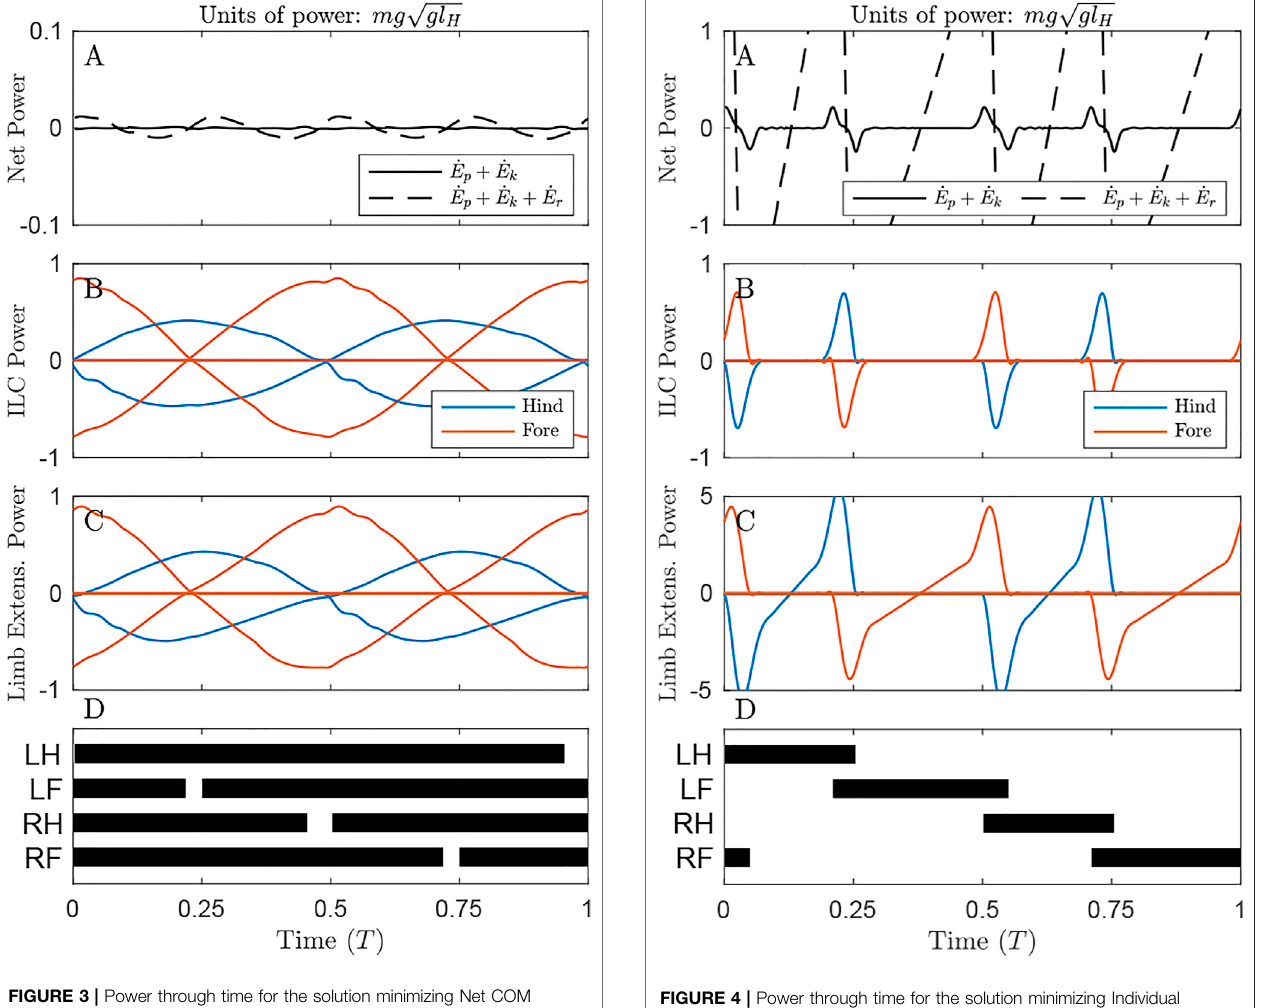
FIGURE 4 | Power through time for the solution minimizing Individual Limbs COM Work under the distributed mass model. (A) There is a small oscillation of the Net COM Power (black line), but very large oscillations in the system energy changes (dash line) due to pronounced pitching (Supplementary Video S1) . (B) Individual Limbs COM Power (ILCP) exhibits positive and negative peaks at transfer of support. Some power is inevitable due to redirecting the COM from a downward to upward trajectory. (C) The Limb Extension power is considerable, even during periods where ILCP is zero. Note that the y -axis here is 5 times that of Figures 3C , 5C . (D) The gait involves alternating periods of single and double